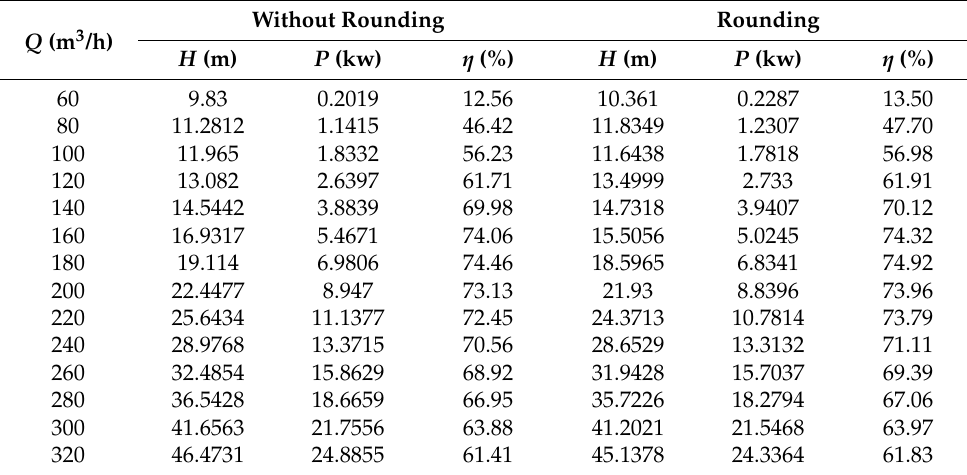
Table 3. Comparison of PAT without rounding and with rounding at 1000 rpm.